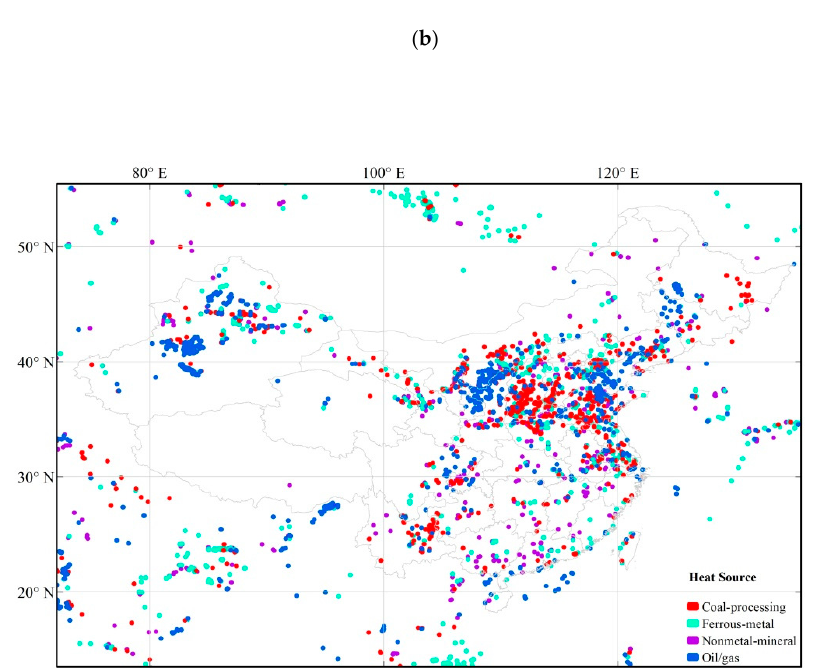
Figure A6. The distributions of emitting point sources from ( a ) CARMA and ( b ) heat source detected by satellite observations in China.